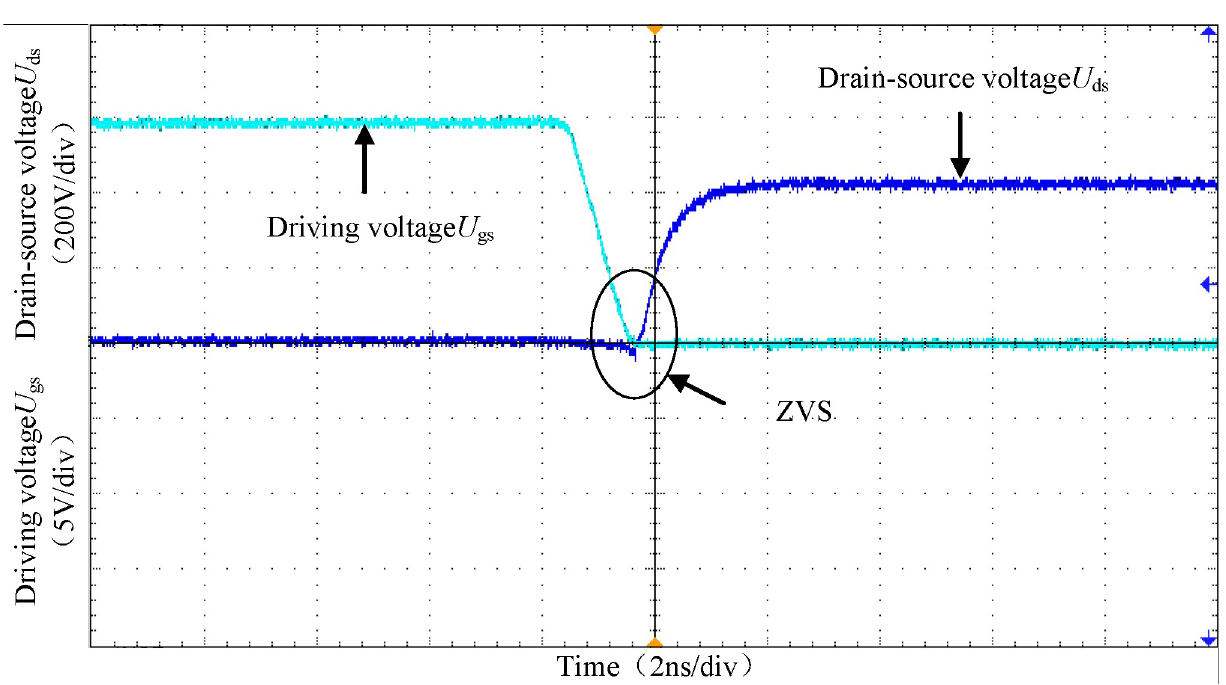
Fig 28. The waveforms of the full-bridge switch.